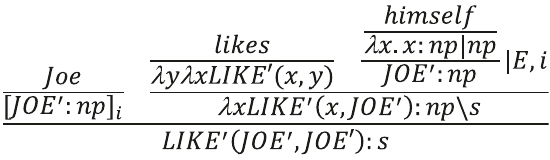
Figure 1: Type Logical derivation of (2).